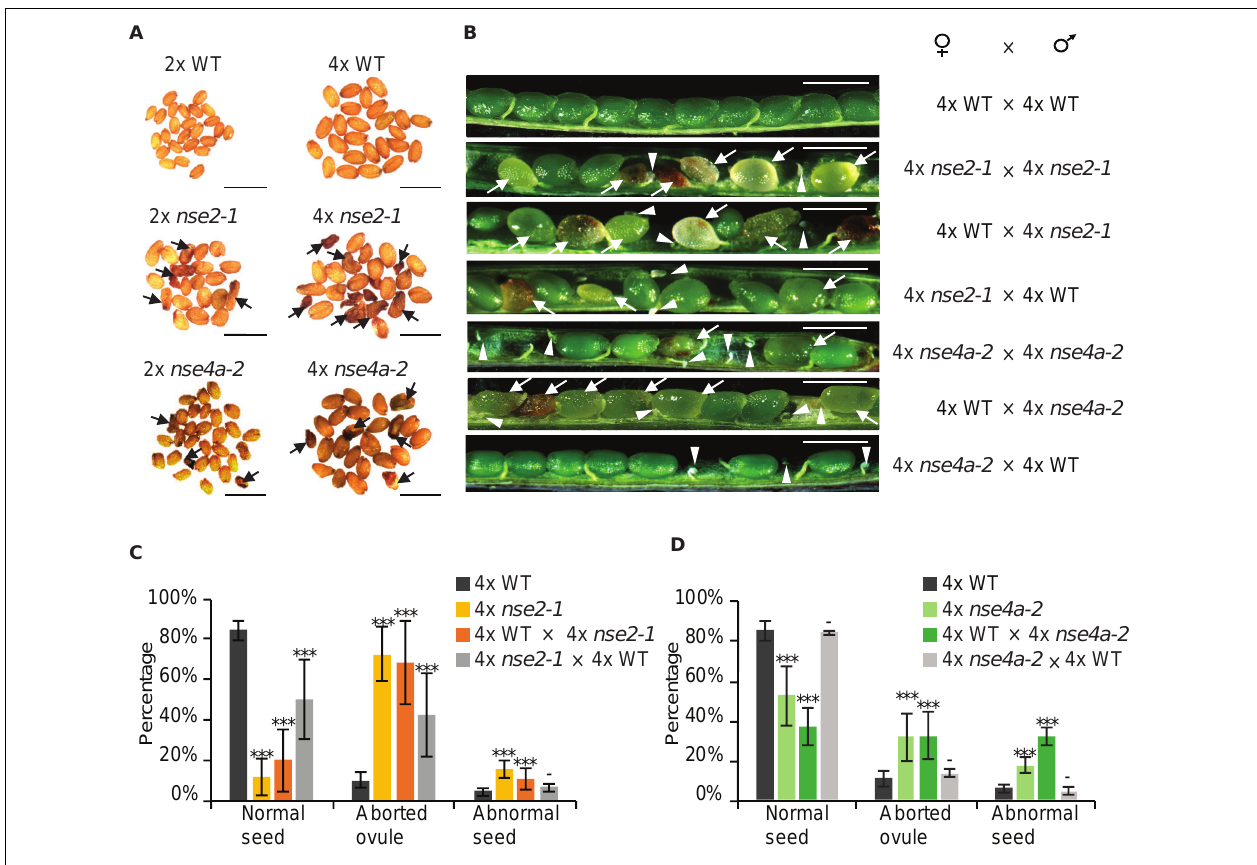
FIGURE 2 | Reduced fertility of tetraploid nse2-1 and nse4a-2 plants. (A) Representative dry seeds of diploid (2x) and tetraploid (4x) WT, nse2-1 , and nse4a-2 plants. Arrows indicate examples of shrunken seeds. Scale bars = 1 mm. (B) Opened siliques 13 days after pollination (DAP). Aborted ovules are marked with arrowheads and abnormal seeds (typically shrunk, brown/pale, or partially transparent) with arrows. Scale bar = 1 mm. (C,D) Frequencies of normal seeds (NS), aborted ovules (AO) and abnormal seeds (AS) in manually pollinated 4x WT, 4x nse2-1 , and 4x nse4a-2 plants and their F1 reciprocal crosses. Error bars represent standard deviation among the means of three individual plants. Significance in Fisher’s exact test relative to 4x WT in the given group (NS, AO, AS): − = P > 0.05 , * = P < 0.05, ** = P < 0.01 , and *** = P < 0.001 . Source values and basic counts are provided in Supplementary Table 1 .